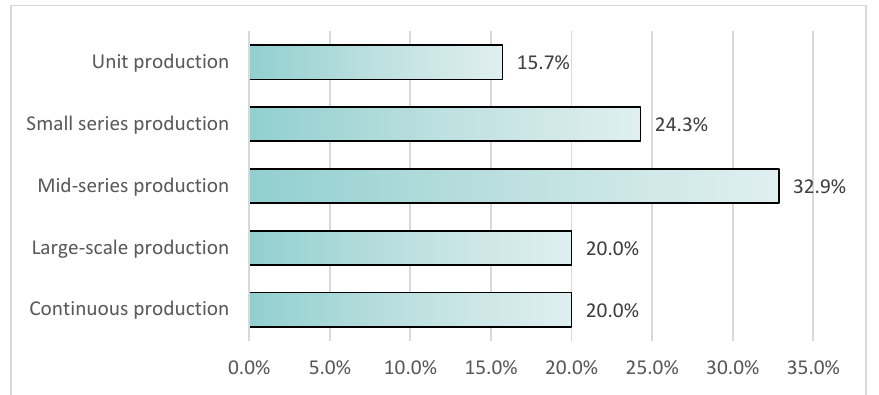
Figure 5. Percentage of questionnaires indicating the use of a specific type of production (one company can carry out several types of production).